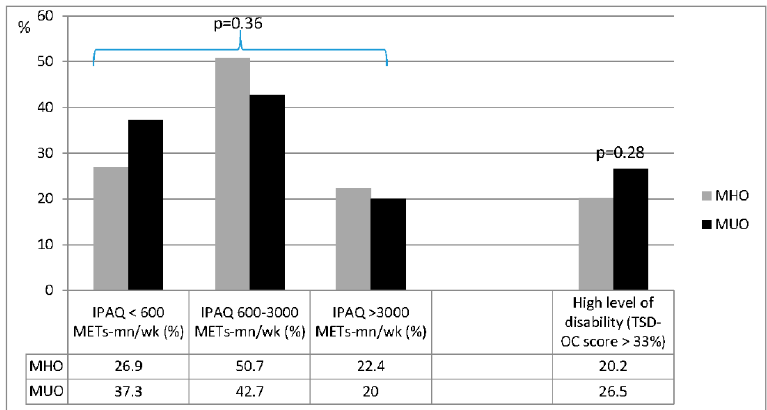
Figure 2. Prevalence of disability and physical inactivity in metabolically healthy obese (MHO) and metabolically unhealthy obese (MUO) subjects. IPAQ: International Physical Activity Questionnaire; TSD ‐ OC: Test SIO for obesity ‐ related disability.